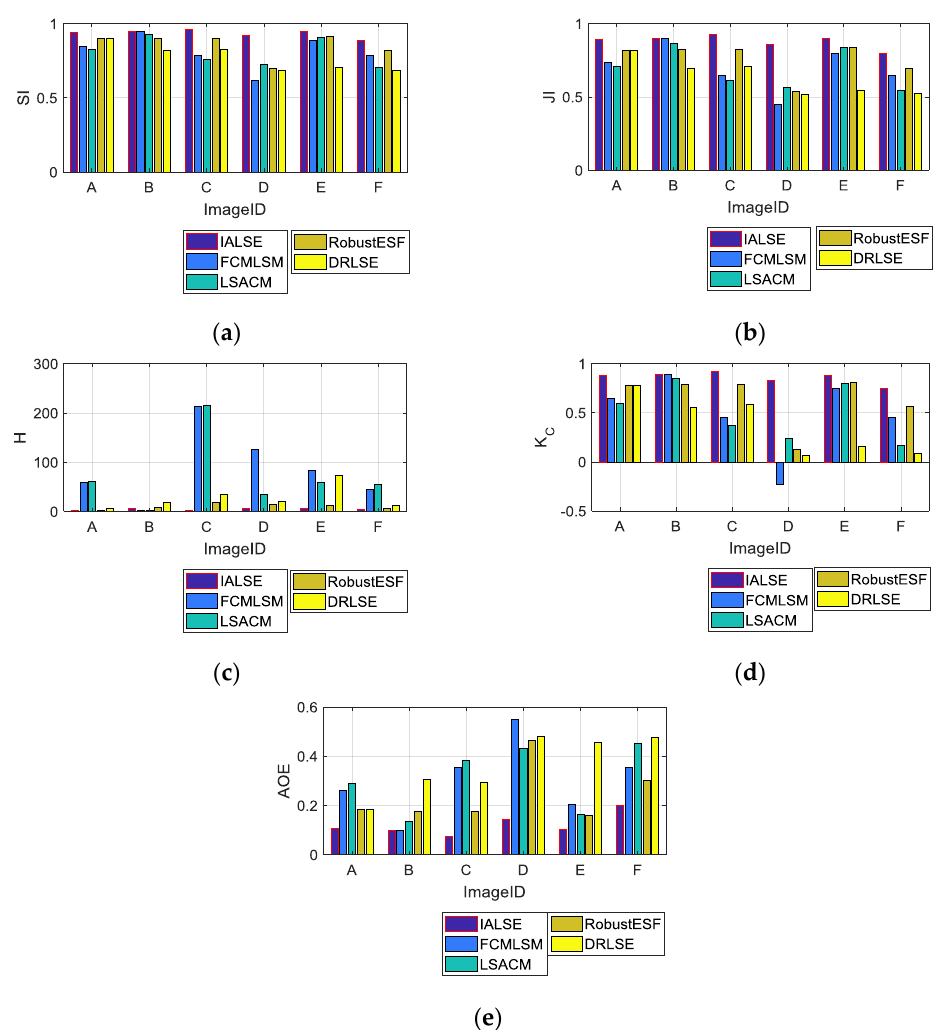
Figure 8. Ground truths.